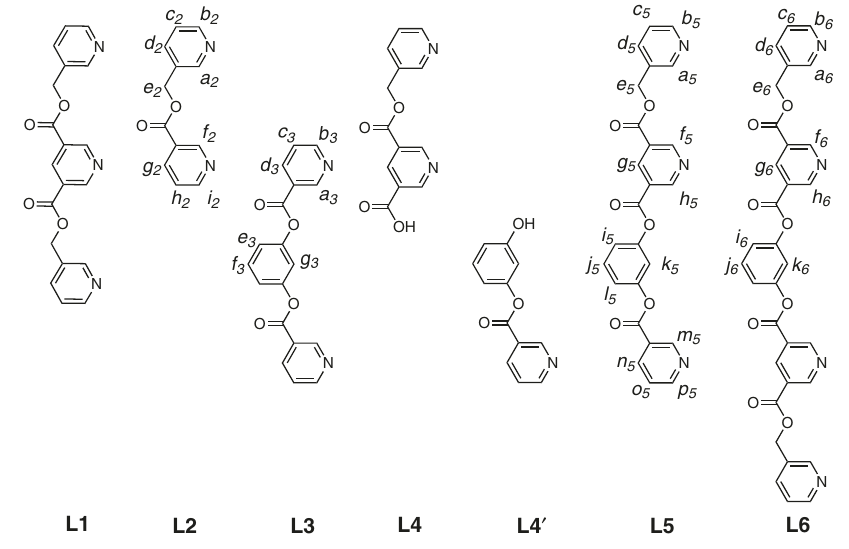
Fig. 2 Structure of the ligands. The ligands L1 – L6